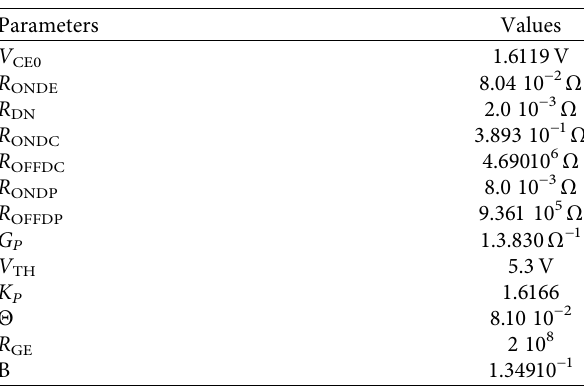
Figure 7: Organizational chart of the optimization approach applied to the IGBT model. Table 2: IGBT electrical parameters